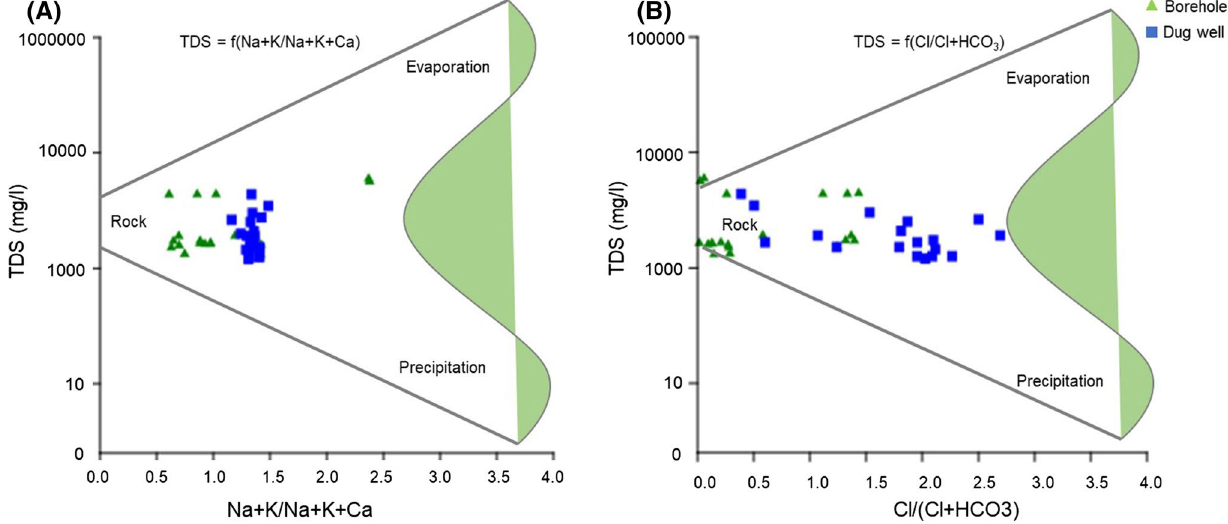
Fig. 9 Gibbs plot showing major natural mechanisms controlling groundwater